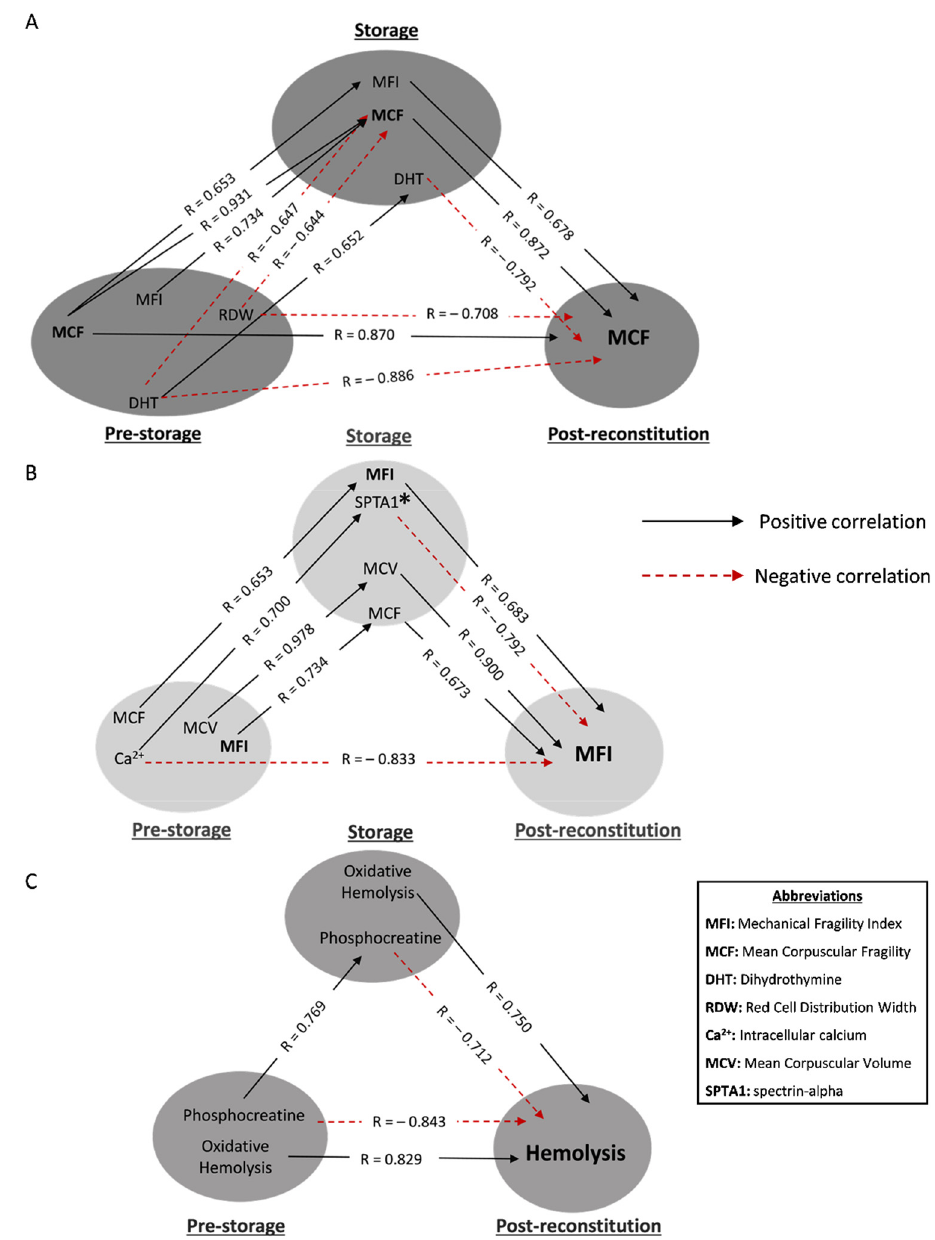
Figure 3. Statistically significant hemolysis correlations between freshly drawn blood, stored, and reconstituted RBCs from beta-thalassemia trait ( β Thal + ) donors. The correlation triangles focus on ( A ) osmotic, ( B ) mechanical and ( C ) spontaneous hemolysis of reconstituted samples. All connec- tions represent repeatable (at every recipient plasma and storage time-point measured) significant correlations. The R-values concern late storage and thalassemic plasma. * SPTA1 was used as an example of an array of structural components that correlate with MFI (e.g., ankyrin-1, glycophorin C and 4.2 protein).